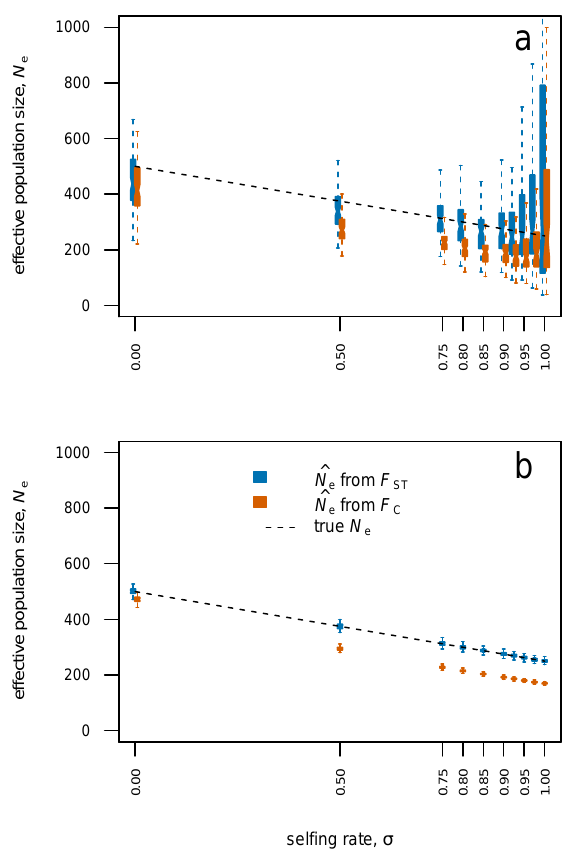
Figure 8 – Effective population size estimates from temporal differentiation from F C and F ST . Estimates obtained from simulated data of populations of N = 500 diploid indi- viduals, sampled twice with τ = 25 generations between samples and 100 estimates at independent simulation replicates. Dashed line marks true N e = performed with SLiM (Messer, 2013) as described in the main text and presented par- tially in Fig. 1. (b) Simulations performed with a simple model of independent loci with initial allele frequency of 0.5, as described in appendix